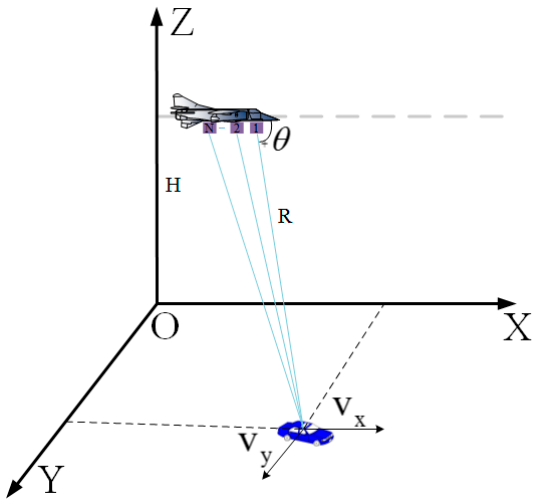
Figure 1. Geometry of the multichannel radar system.